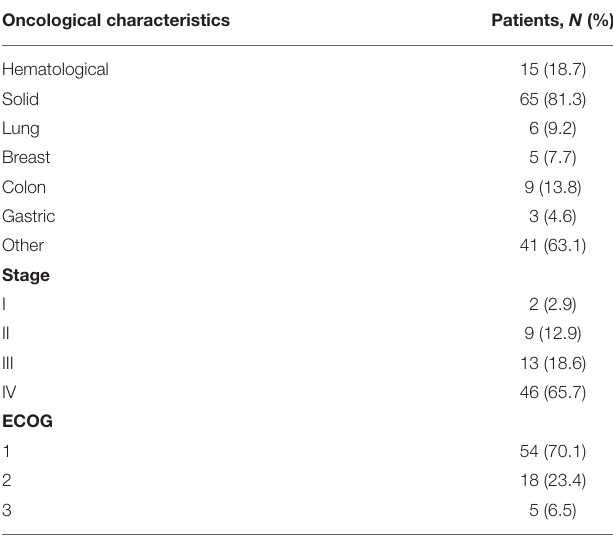
TABLE 2 | Patients’ characterization according to oncological or non-oncological status. Oncological characteristics